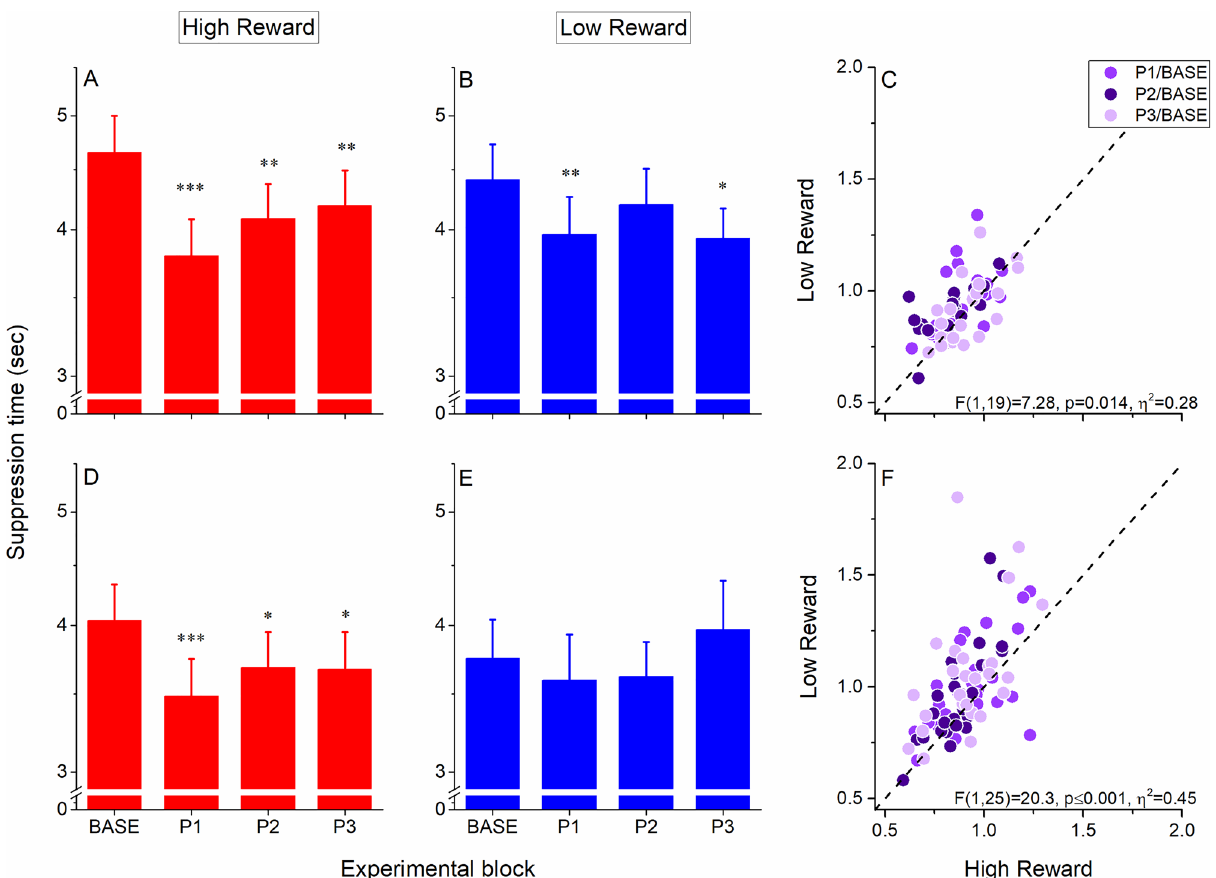
Figure 3. Effect of monetary reward on conscious access. Data from experiment 1 showing suppression times acquired in the b-CFS paradigm before (BASE) and after (P1-P2-P3) associative learning between visual stimuli orientation and monetary reward. Average ( N = 20) suppression times of visual stimuli associated with high ( A ) and low ( B ) monetary reward in Experiment 1. Error bars represent 1 ± S.E.M. Suppression times were analyzed after a log10 transformation, for this reason, the y axis is in log10 scale. ( C ) scatter plot of the ratio between suppression times measured after (P1, P2 and P3, symbols with progressive shades of purple) and before (BASE) associative reward learning for stimuli associated with High vs Low monetary reward in Experiment 1. ( D-F ) Same as A-C for Experiment 2 ( N = 26). Asterisks represent the significance level (Bonferroni-Holm correction for multiple comparisons applied) of post-hoc tests for P1, P2 and P3 vs BASE: *** = corrected p < 0.001, ** = corrected p < 0.01, * = corrected p <